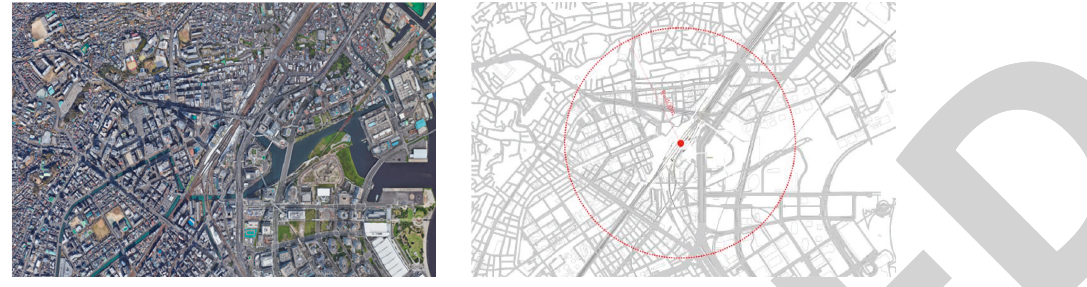
Figure 1: Overview of the study area: schematic of Yokohama station. Table 1: Twenty station catchment areas for the current empirical case study.